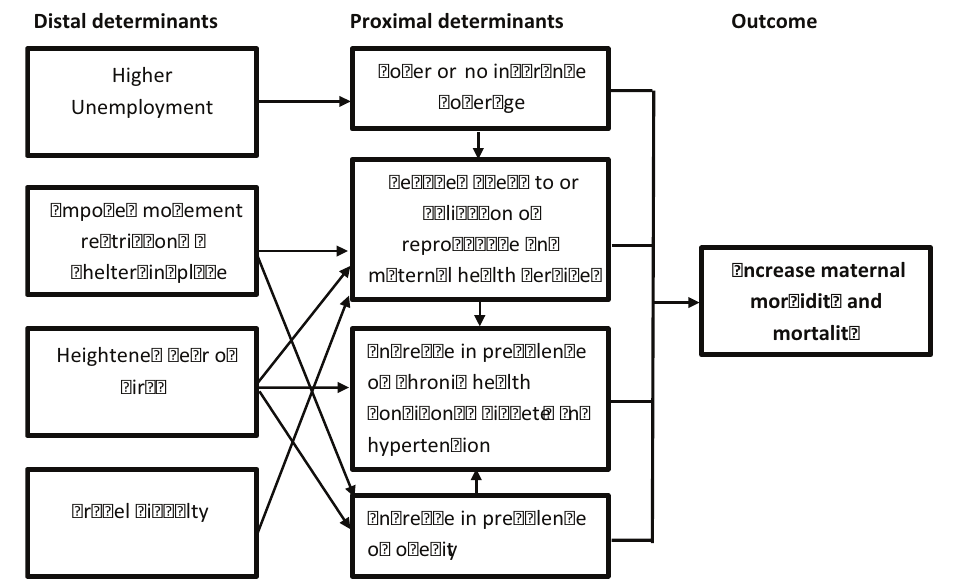
Figure 1: A theoretical framework to explain a projected increase in maternal mortality and severe maternal morbidity in US Afri- can American women in the era of COVID-19